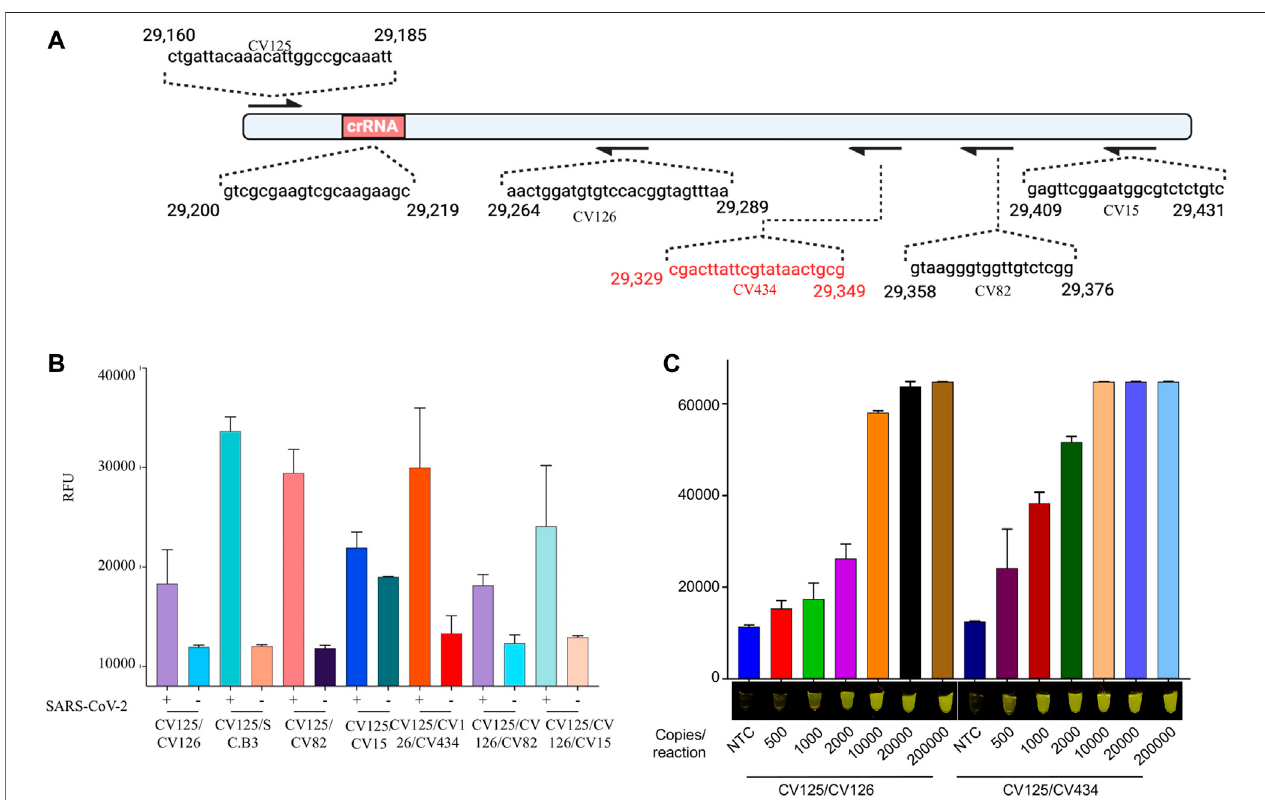
FIGURE 3| iSCAN-V2demonstrates a high level of sensitivity for synthetic SARS-CoV-2 RNA detection. (A) Schematic of the SARS-CoV-2 N gene fragment. The forward (F) primer and multiple reverse (R) primers are represented by arrows and their sequence on the N gene fragment. (B) Limit of detection (LOD) determination of iSCAN-V2. Synthetic SARS-CoV-2 RNA (500, 1,000, 2000, 10,000, 20,000, and 200,000 copies/reaction) was subjected to the iSCAN-V2 detection platform using multipleprimersets. (C) LODdeterminationofiSCAN-V2.SyntheticSARS-CoV-2RNA(50,100,200,1,000,2,000,and20,000copies/reaction)wassubjectedto the iSCAN-V2 detection platform using primer sets CV125/CV126 and CV125/CV434. CFX96 (Bio-Rad) end-point fl uorescence (1 h) readouts were converted to graphical format using GraphPad Prism. For end-point fl uorescence data presentation, error bars (cid:1) means ± SD ( n (cid:1) 3). End-point fl uorescence was imaged in a P51 molecular fl uorescence viewer. For real-time representation, the intensity of the fl uorescent signal was measured every 2 min for a period of 1 h. Values shown in the graphs are means of 3 independent readings. NTC, no template